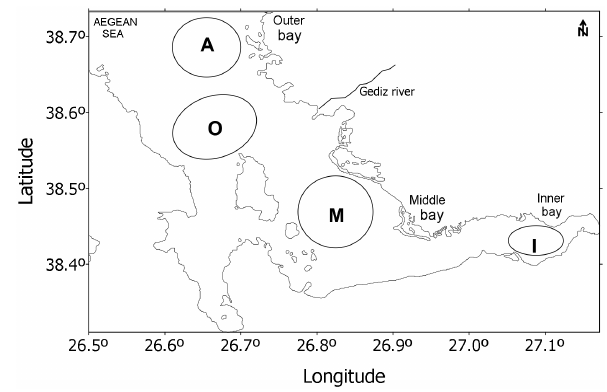
Figure 9. Frequently seen recirculation pattern in ˙Izmir